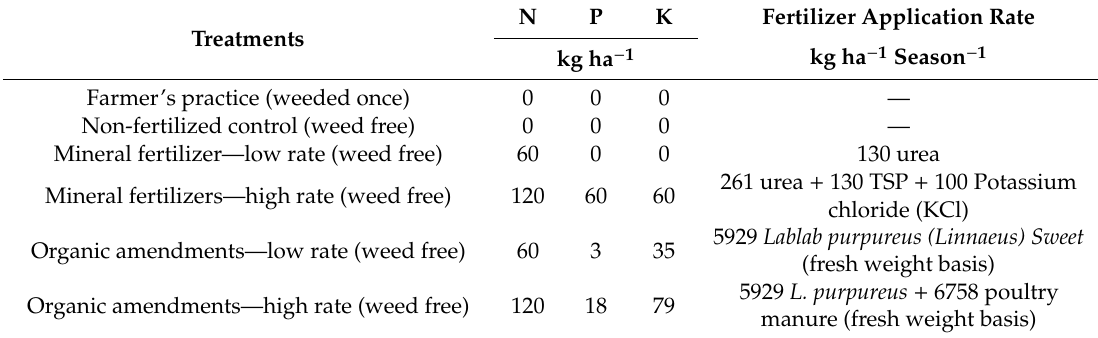
Table 1. Crop management options tested at three hydrological positions within an inland valley wetland in Uganda during three dry cropping seasons